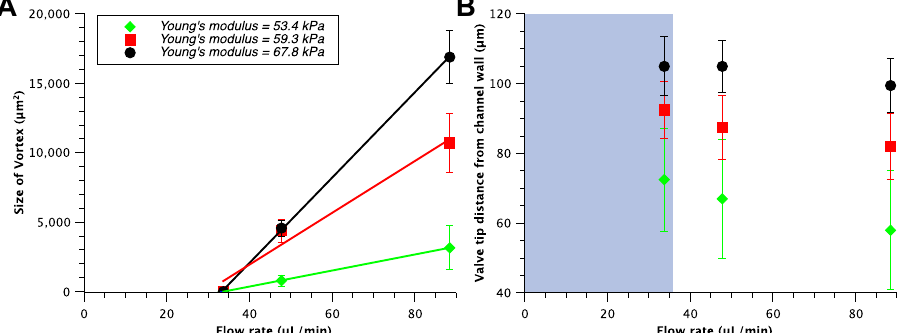
Fig. 3 Vortex size dependence on fl ow rate for three different stiffnesses of the valve. a The size of the vortex increases linearly as the fl ow rate and/or the stiffness increases. The lines are linear fi ts. b Dependence of the degree of valve opening on fl ow rate for three different valve stiffnesses. Here, the smaller the distance from the channel wall the more the valve is open. As a consequence, for more fl exible valves (lower Young ’ s modulus) the distance from the channel wall is smaller for a fi xed fl ow rate compared to more rigid valve and the vortex associated is smaller (see panel a ). In the plot, the grey area represents the region where no vortices were observed, independently of the stiffness of the valve tested. The error bars represent standard